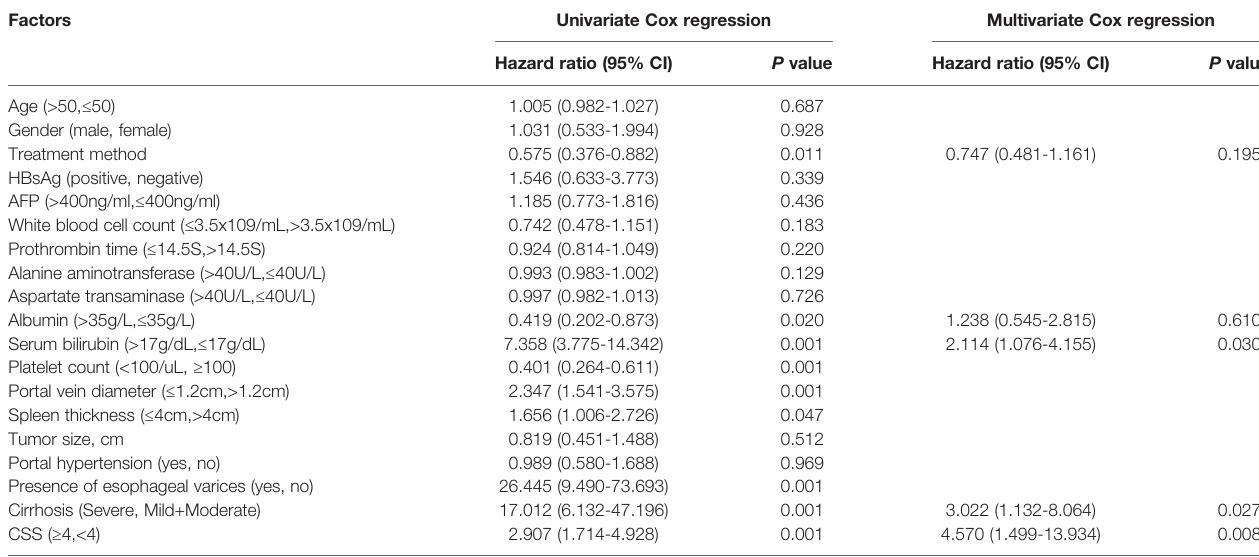
TABLE 3 | Univariate analysis of prognostic factors of disease-free survival rate. Factors